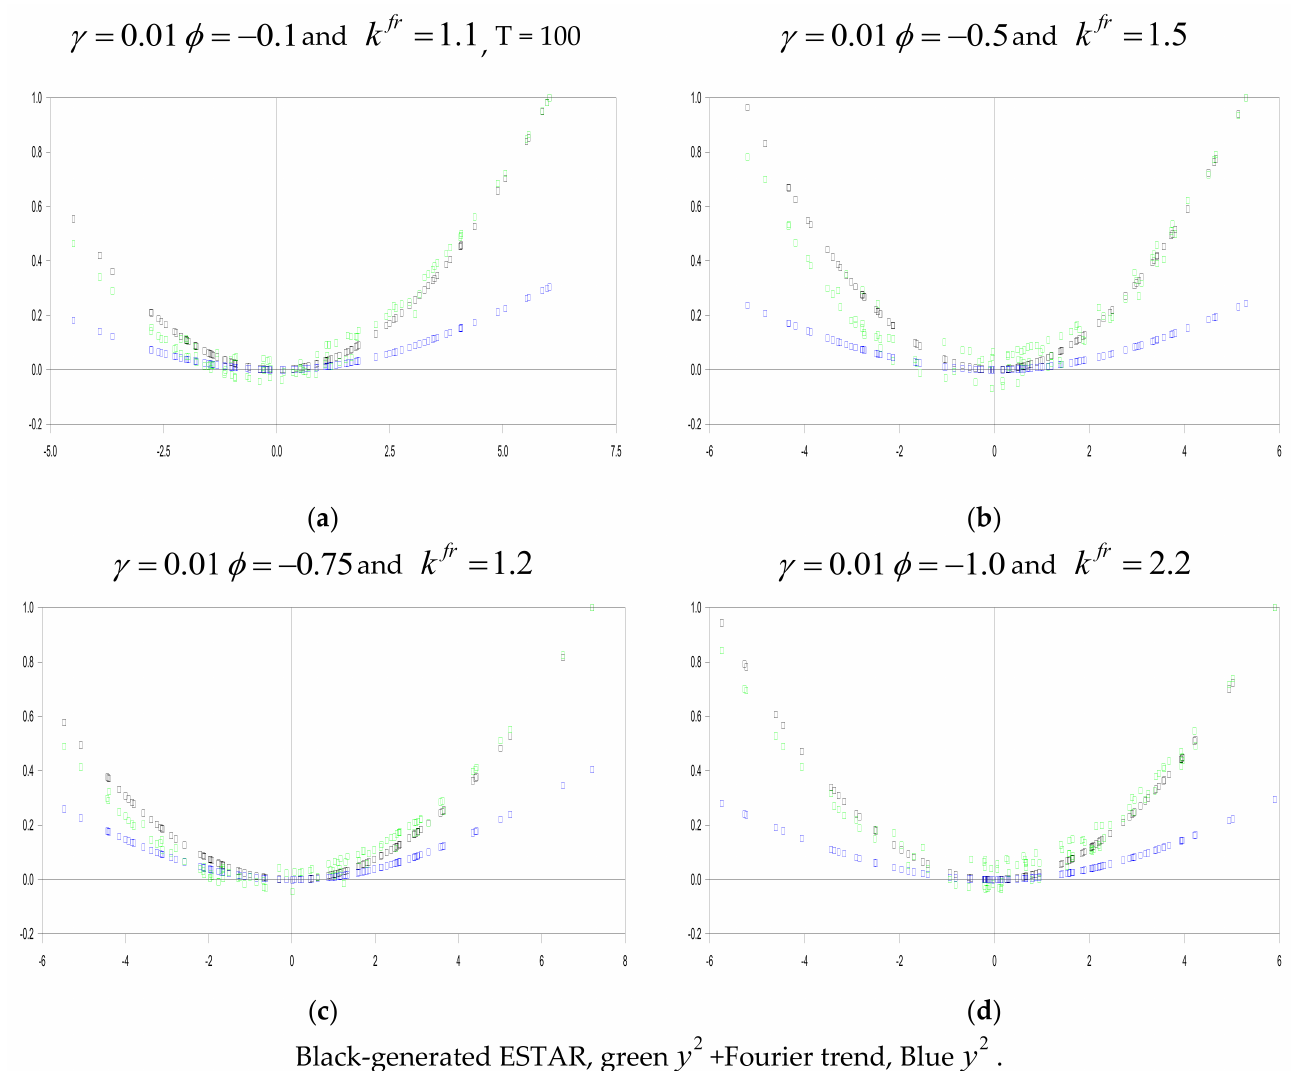
Figure 3. Generated ESTAR (1) Taylor expansion and Fourier adjustment: the parameter values are given in the boxes above each panel. The functions colored black are ESTAR functions obtained by using the parameters. The functions colored blue show the squared forms obtained by the Taylor approximation. Finally, the functions colored green display the retrieval of the original ESTAR function by adding the squared form obtained by the Taylor approximation and Fourier